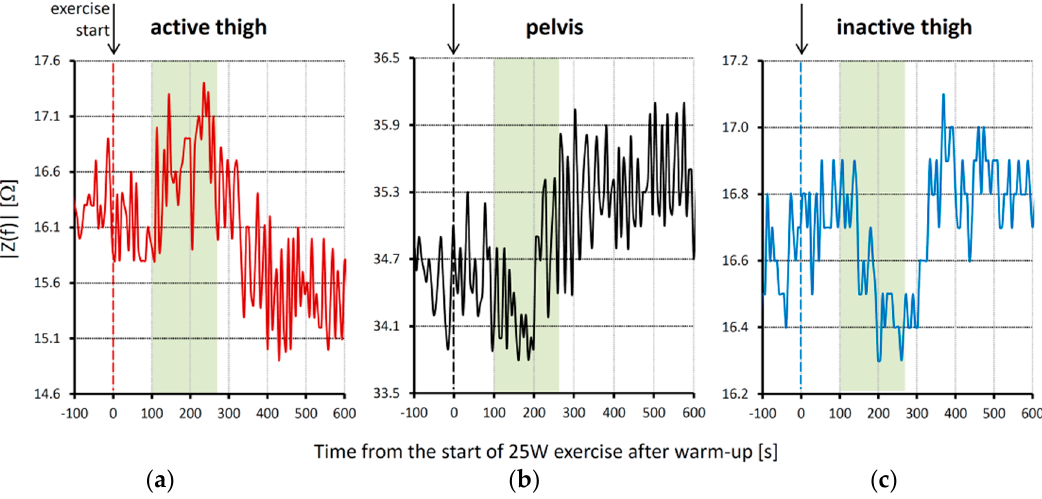
Figure 6. Changes of |Z (f) | at f = 48 kHz associated with the start of 25 W exercise after warm-up in three body districts (same experimental session of Figure 5): ( a ) active thigh; ( b ) pelvis area; ( c ) inactive thigh. The vertical lines at time zero indicate the start of 25 W exercise after warm-up. Please note the transient increase of impedance magnitude in the active thigh 100 s after the start of exercise, a simultaneous impedance decrease in the pelvis area, and a decrease of impedance in the inactive thigh that follows the impedance decrease in the pelvis. The green box highlights the time period corresponding to the transient impedance increase in the active thigh.